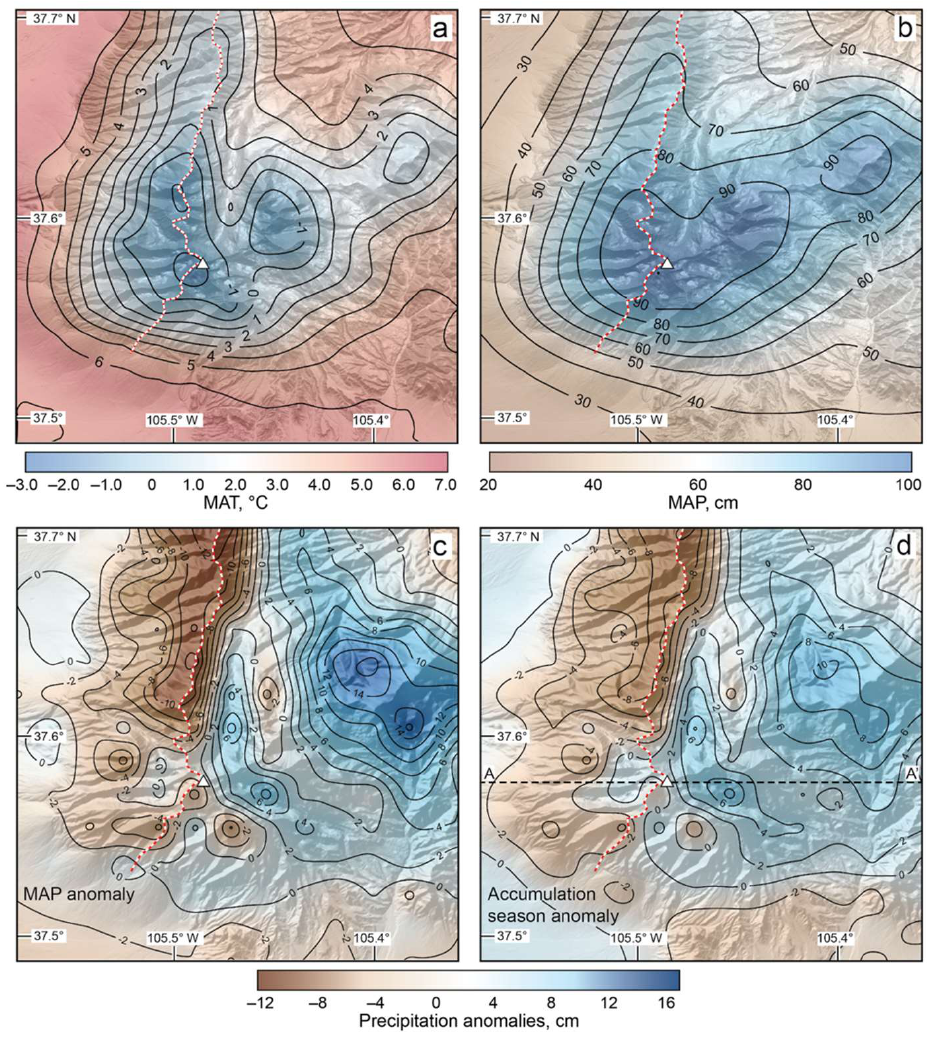
Figure 2. Modern climate on the Blanca Massif based on the PRISM gridded climatology. ( a ) Mean annual temperatures (MAT). ( b ) Mean annual precipitation (MAP). ( c ) Precipitation anomalies defined by the residual between PRISM MAP values and those based on a regression of precipitation on elevation ( r 2 = 0.93, p < 0.0001, n = 182). ( d ) Similarly defined precipitation anomalies for the accumulation season (October through April; r 2 = 0.94, p < 0.0001, n = 182). White triangle is Blanca Peak. The red and white dashed line delineates the range crest in the north and defines the eastern and western sides of the massif as defined in this study. Line A-A’ in ( d ) is the cross-section shown in Figure